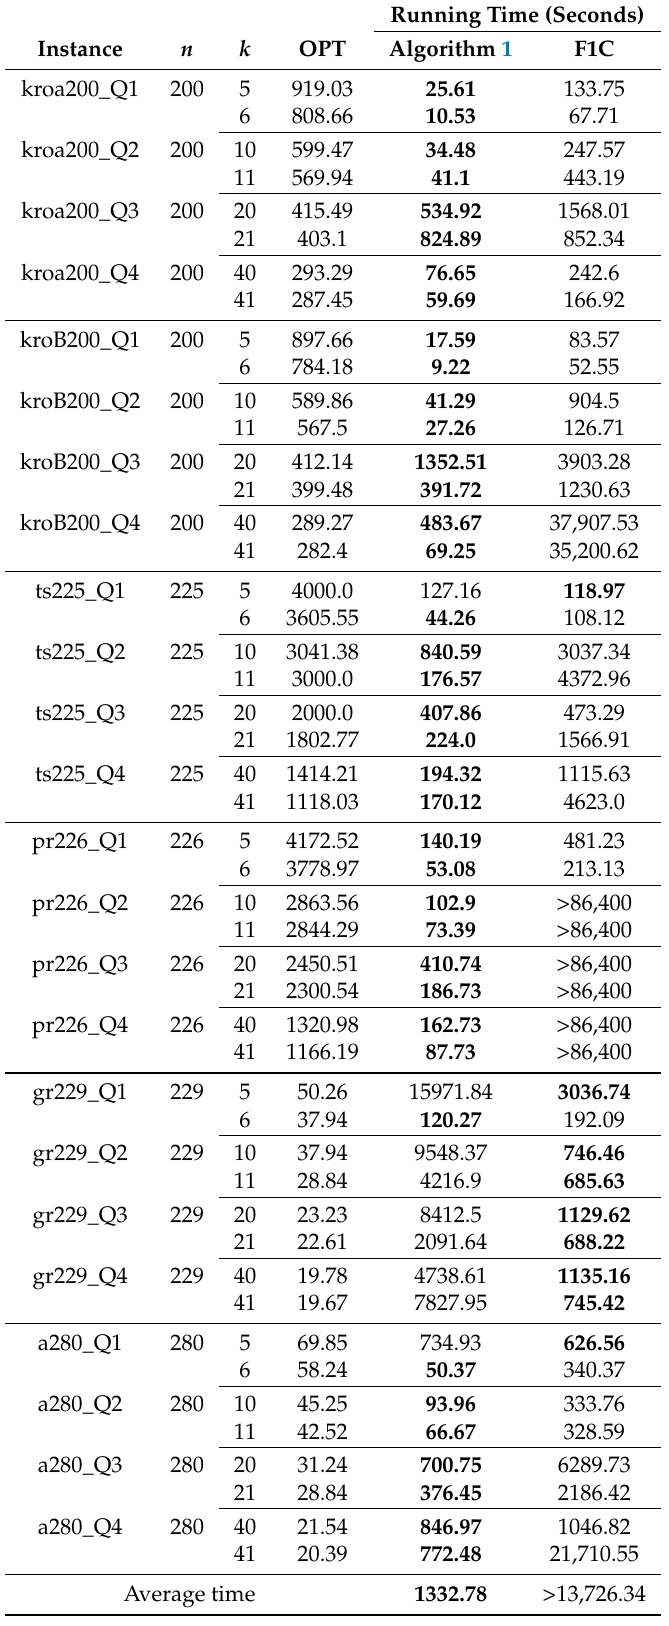
Table 2. Running time and optimal solution size found by Algorithm 1 and the classical formulation F1C over Set 2 using Gurobi 9.0.0. Best running times are in